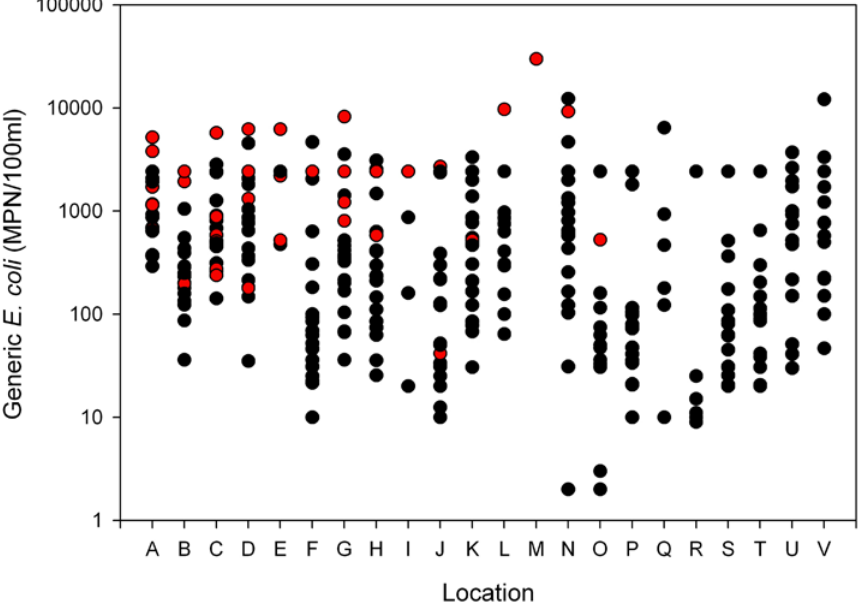
Figure 3. Concentration of genericE.coliin the Salinas watershed. Sample locations refer to Figure 1. Red and black dots indicate isolation or non- isolation of EcO157 for the corresponding duplicate water samples, respectively.